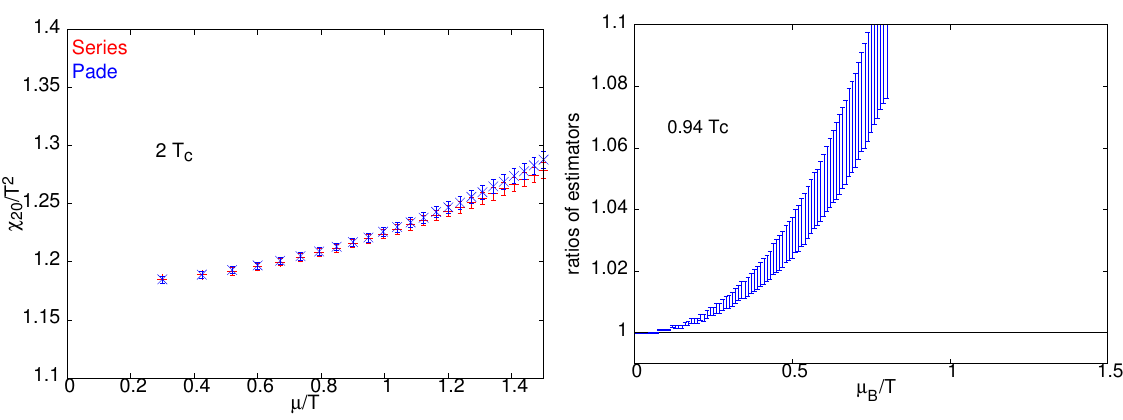
with the series summed one, at T B